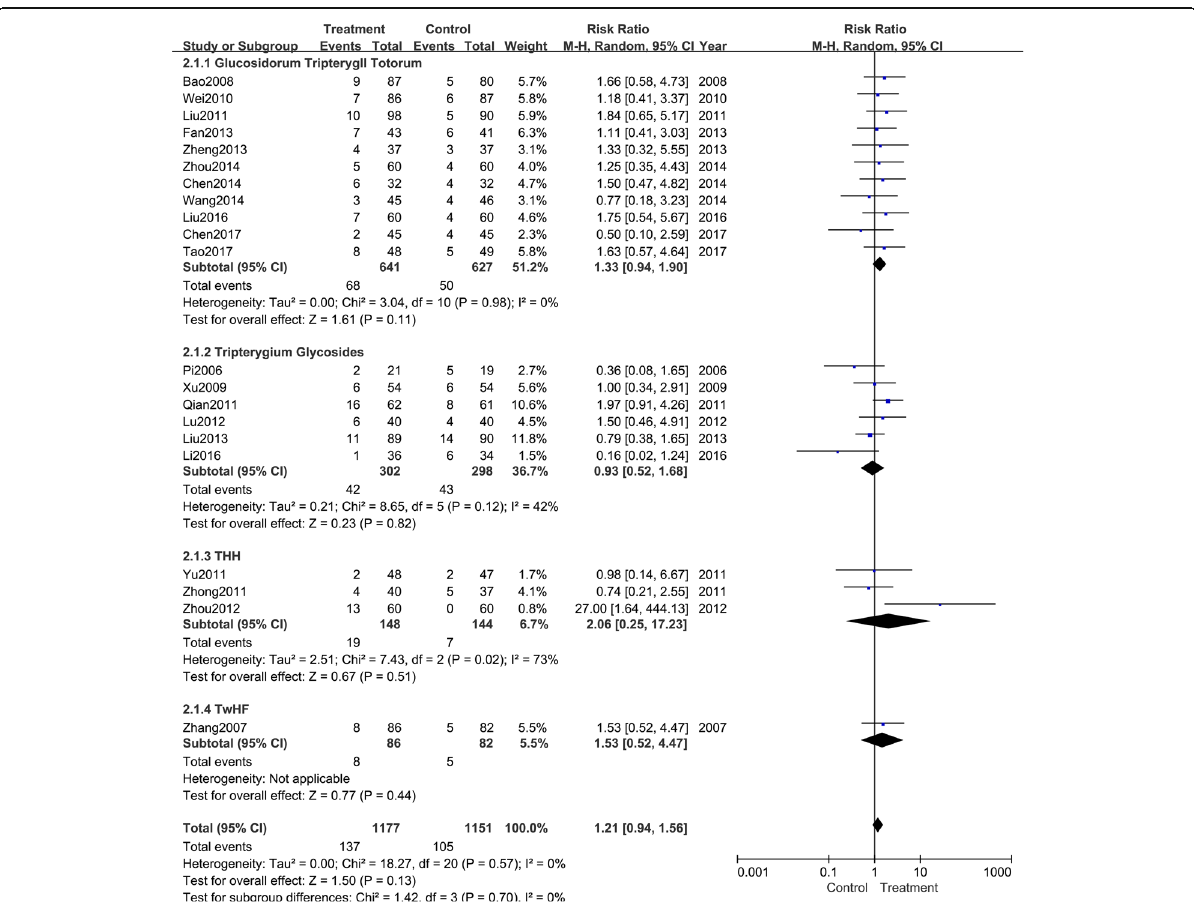
Fig. 5 Meta-analysis of adverse events of Tripterygium preparations combined with antihistamines versus antihistamine. CI indicates confidence